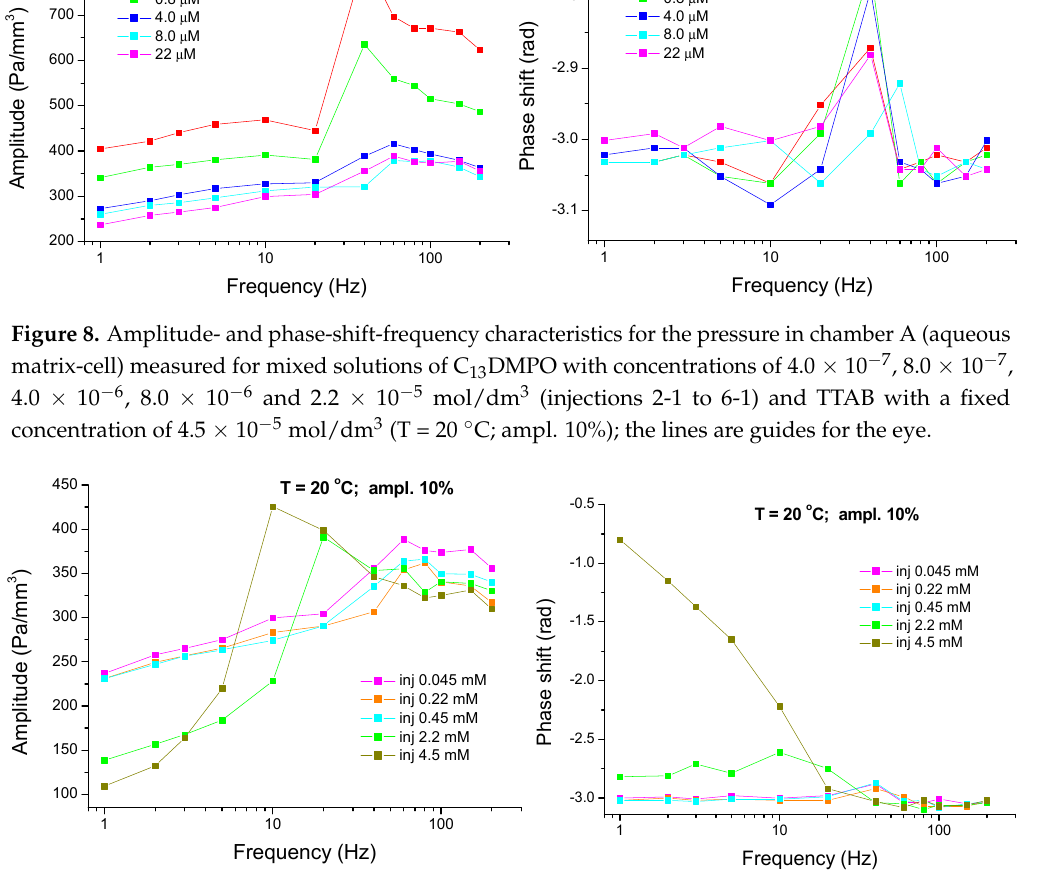
Figure 9. Amplitude- and phase-shift-frequency characteristics for the pressure in chamber A (aqueous matrix-cell) measured for mixed solutions of TTAB with concentrations of 4.5 × 10 − 5 , 2.2 × 10 − 4 , 4.5 × 10 − 4 , 2.2 × 10 − 3 and 4.5 × 10 − 3 mol/dm 3 (injections 6-1 to 6-5) and C 13 DMPO with a fixed concentration of 2.2 × 10 − 5 mol/dm 3 (T = 20 °C; ampl. 10%); the lines are guides for the eye.